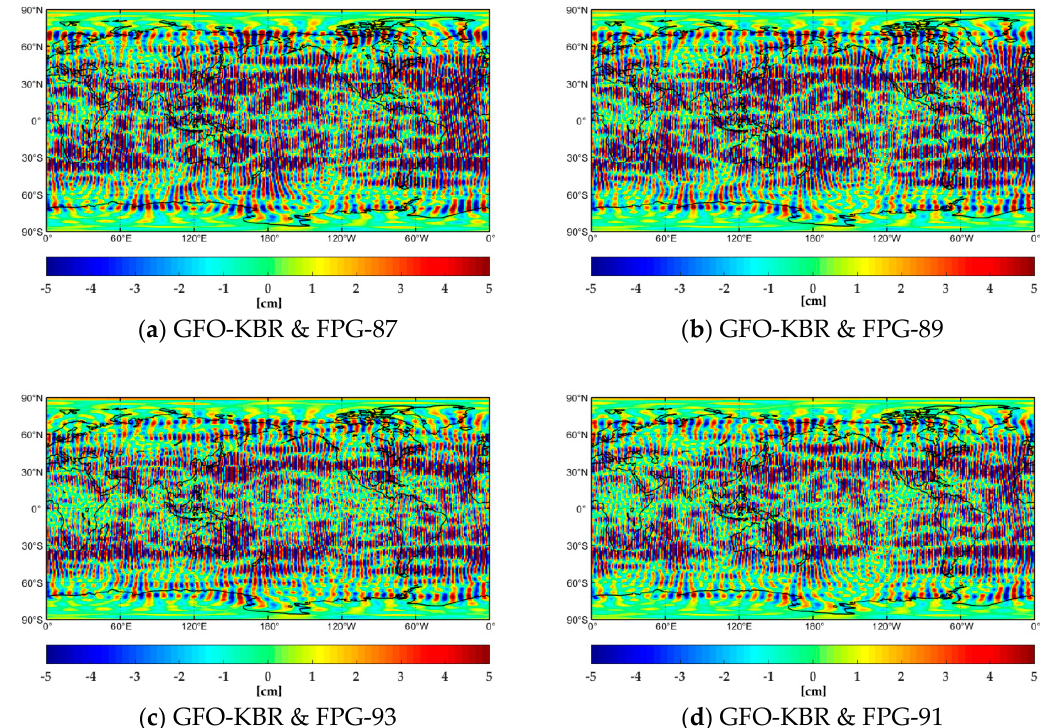
Figure 6. Global spatial differences plots (SDP) of different GFO-KBR & FPG combined models in January 2006: ( a ) GFO-KBR & FPG-87; ( b ) GFO-KBR & FPG-89; ( c ) GFO-KBR & FPG-93; and ( d ) GFO-KBR & FPG-91.